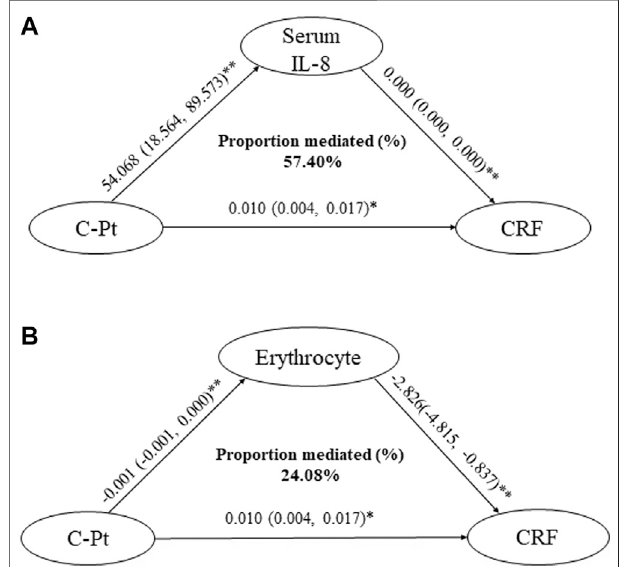
FIGURE 4 | Mediation effect assessments of IL-8 and erythrocytes on theassociationofC-Pt withCRF.a:mediationeffect ofserum IL-8level onthe association of C-Pt with CRF, p < 0.05. b: mediation effect of erythrocyte counts in whole blood on the association of C-Pt with CRF, p < 0.05. *: p < 0.05; **: p <